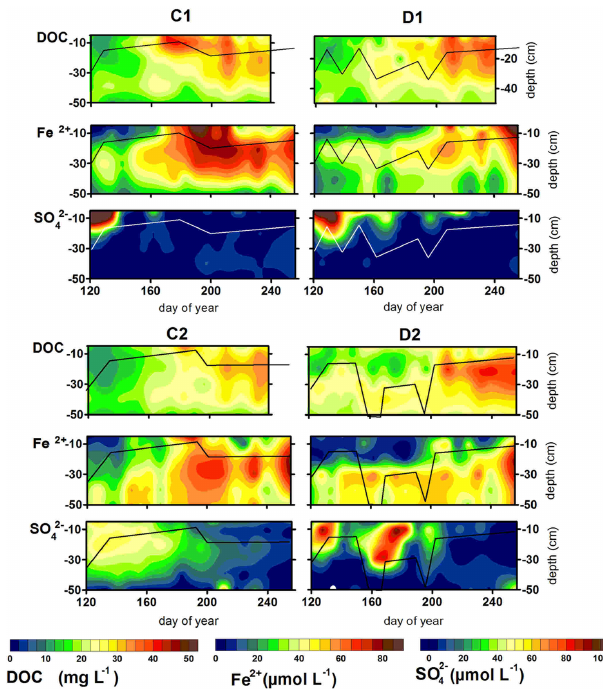
Fig. 5. Porewater DOC, Fe 2 + and SO 2 − concentration dynamics 4 (colour scale) during water table fluctuations in 4 experimental plots in the Schl¨oppnerbrunnen Fen in the Lehstenbach catchment over depth (y-axis) and time (x-axis). Experimental details of the in situ water table manipulation experiments carried out at this site and details about the biogeochemical processes in the plots have been reported elsewhere (Knorr et al., 2009). The colour scale of the so- lutes applies to all 4 plots C1, C2, D1 and D2; the thin solid line represents the approximate water table level in the respective exper- imental plots. Due to measurement problems, the DOC time series ended earlier compared to the Fe 2 + and SO 2 − time series in plots 4 C1, D1 and C2; therefore, the size of the graphs has been adjusted to a similar x-axis scaling. Graphs were interpolated from weekly samplings (7days) over 6 depths (5, 10, 20, 30, 40, and 50cm) with an inverse distance weight approach, as implemented in Surfer Ver- sion 8 (Golden Software, Golden CO,